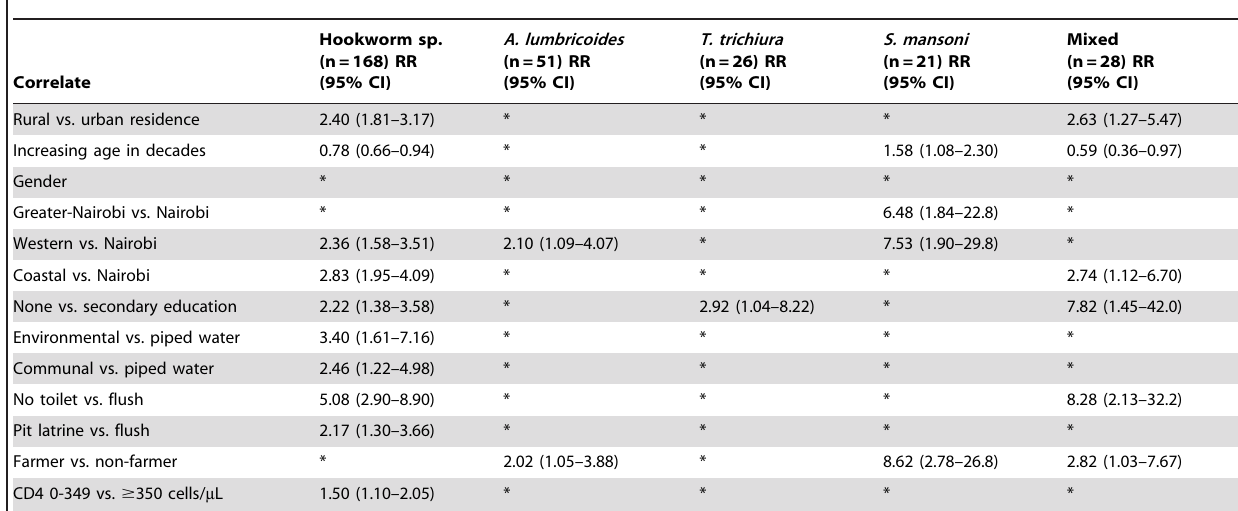
Table 3. Relative risk of species-specific helminth infection associated with study correlates among HIV-1 seropositive adults in Kenya, compared to helminth-uninfected individuals.